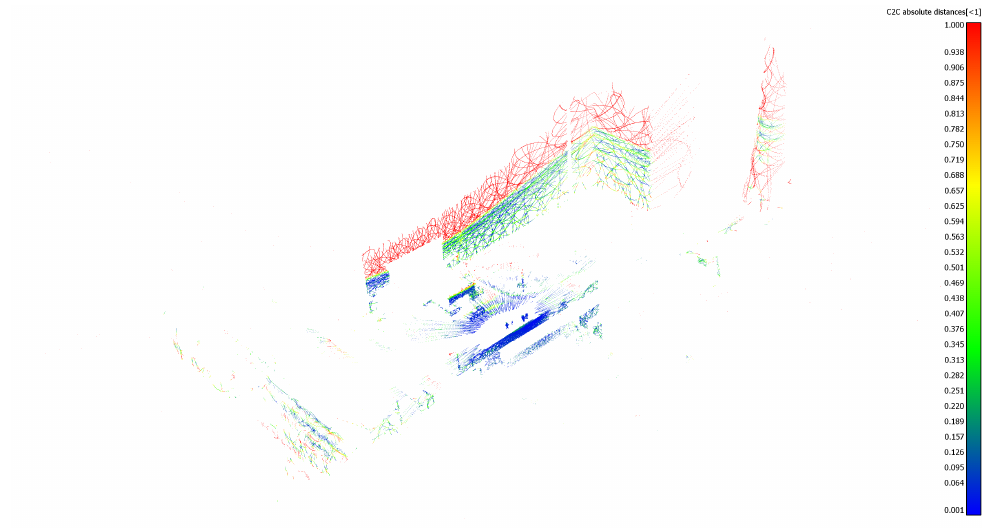
Figure 11. Undistorted, aggregated point cloud built using data from the Livox Mid–40 with the rotated reflector at Zwentendorf NPP. The distance to the reference point cloud from the Velodyne VLP 16 is marked by colors.